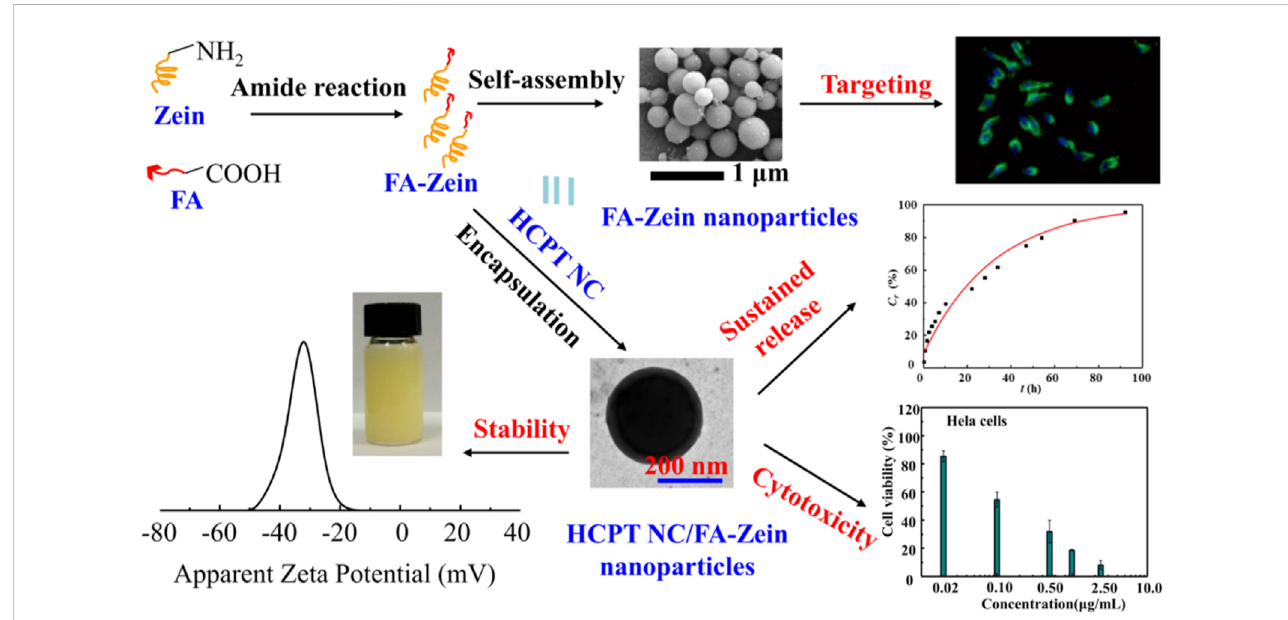
FIGURE 7 Synthesis and characterization of folic acid (FA) cross-linked zein nanoparticles for the targeted delivery of 10-hydroxycamptothecin (HCPT).